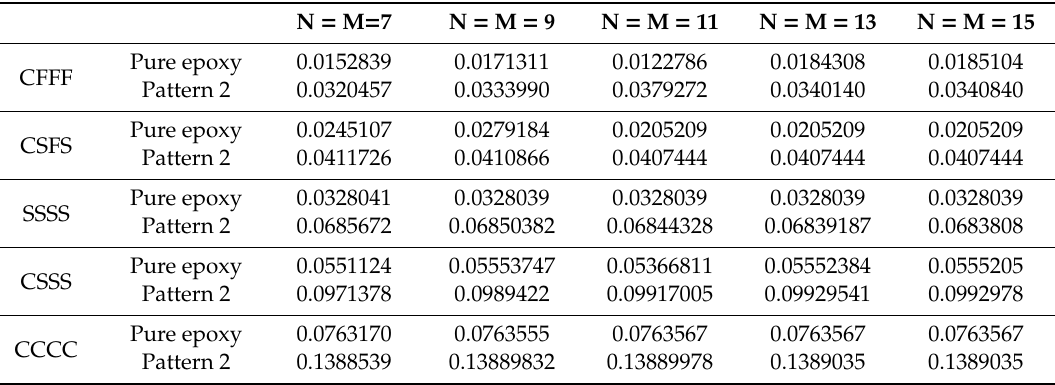
Table 1. The dimensionless natural frequency of the GPLRC panel for di ff erent types of boundary conditions, numbers of grid points and patterns when a / b = 6.5, h = a / 9, R1 = R2 = 10a, ∆ T = 10 (K), and g GPL = 0.5%.